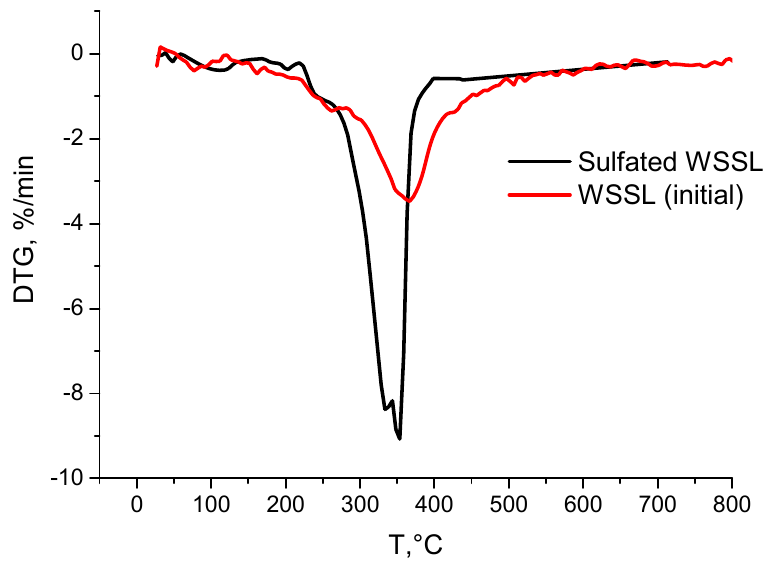
Figure 5. Differential thermogravimetry data. Table 2. Main ranges of thermal decomposition of lignins upon heating at a rate of 10